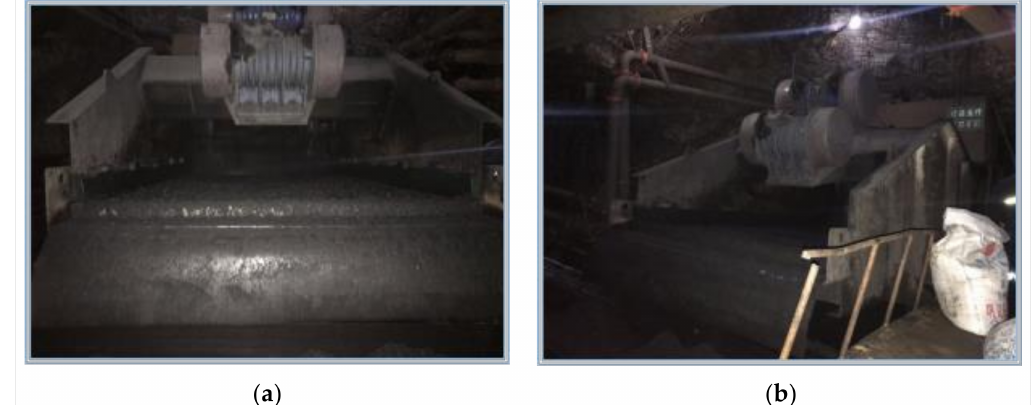
Figure 8. The GPS1837 vibrating sieve in the tailgate of the longwall panel. ( a ) Front view; ( b ) side view. In the field trials, the vibrating sieve is adjusted into the medium frequency